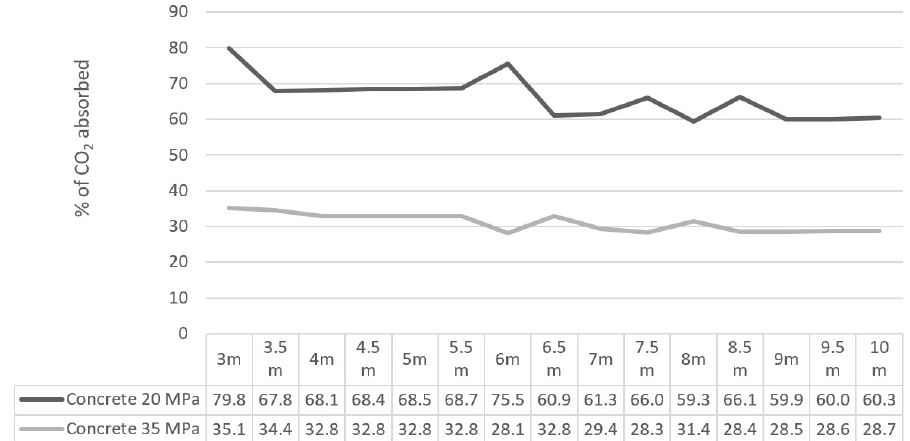
Figure 11. CO 2 capture during the service life of beams dimensioned with 20 and 35 MPa concrete.